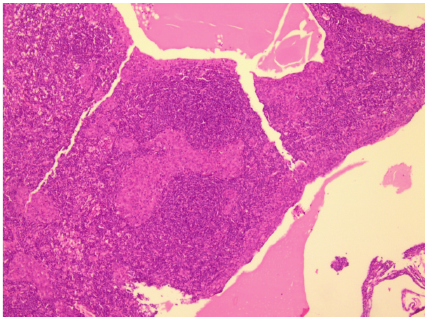
Figure 3: Microscopic view of second patient’s sample. Discrete epithelial nodules with B lymphocytes in follicular figures with microcystic changes are evident; compatible with Micronodular Thymoma WHO classification 2004 (H&E stain ×